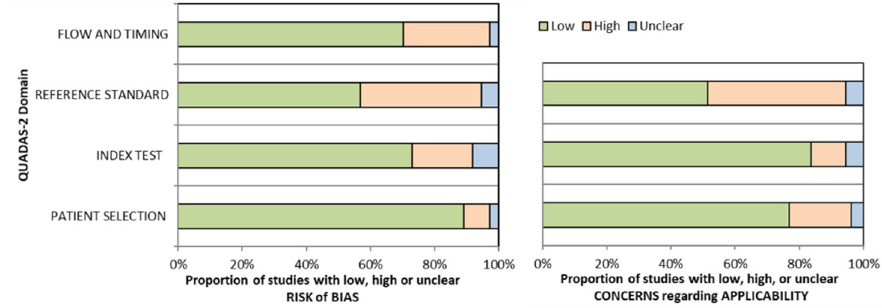
Figure 2. QUADAS-2 assessment of bias and applicability (graphical summary).